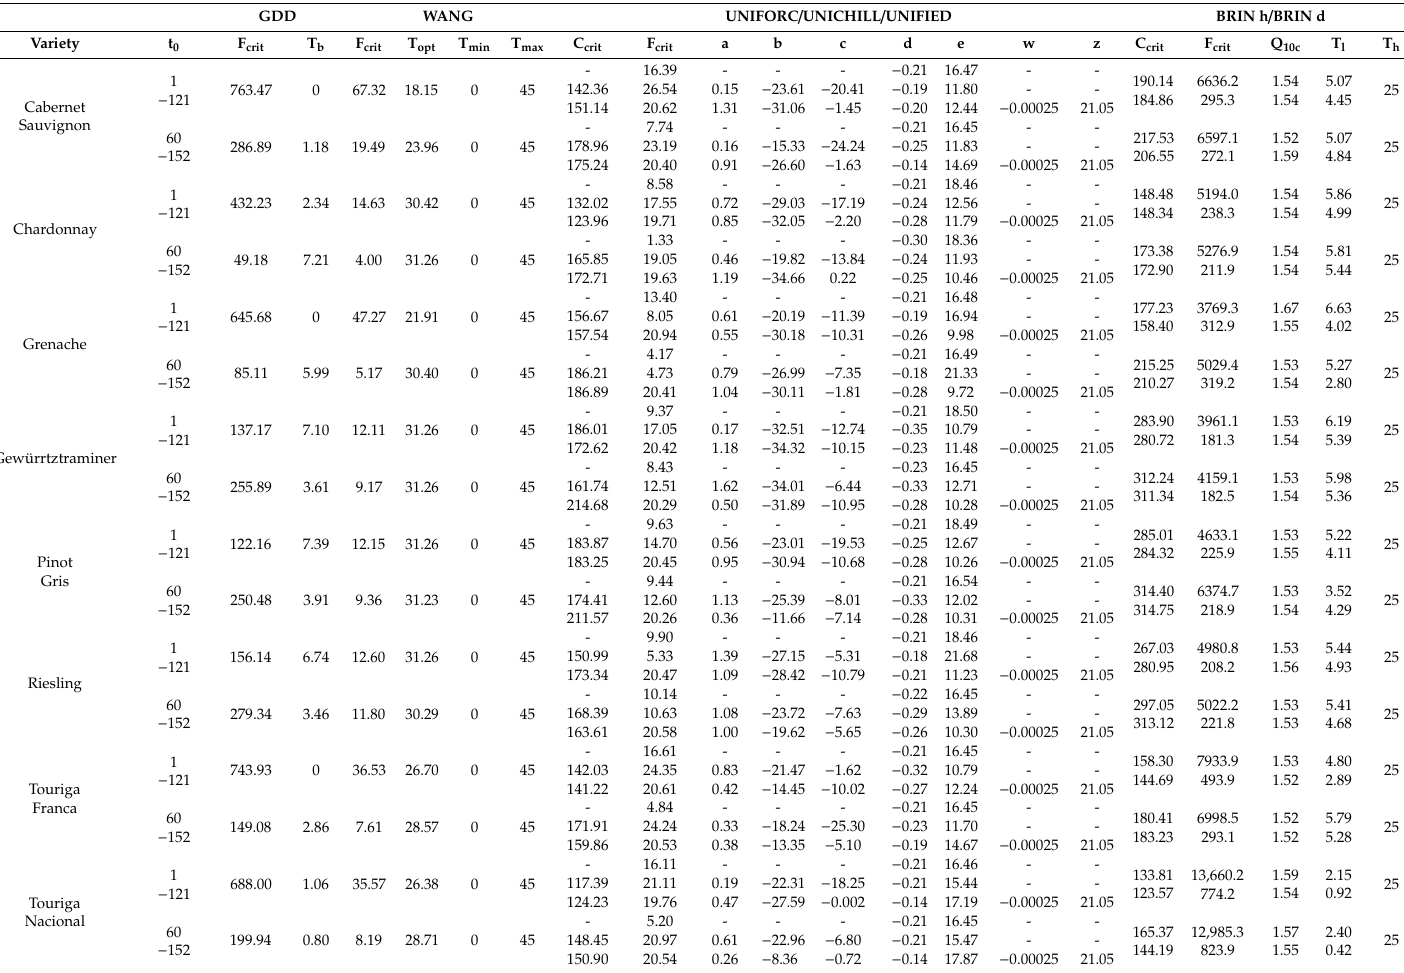
Table 2. HP (highest-performance) parameter sets for each combination of models, grapevine varieties and starting dates. C crit = critical amount of chilling and F crit = critical amount of